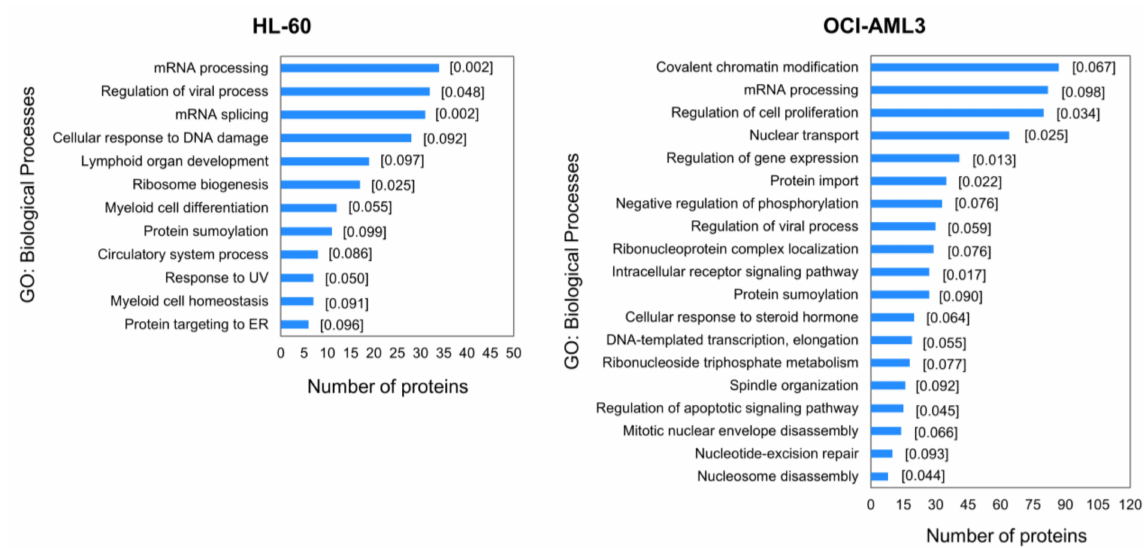
Figure 3. Enrichment analysis for differentially modulated phosphoproteins in HL-60 and OCI-AML3 cells treated with CX-4945. Biological processes significantly represented in phosphoproteomic profile were identified using annotations from GO database. The p -value of modified Fisher Exact Test from DAVID is placed in square